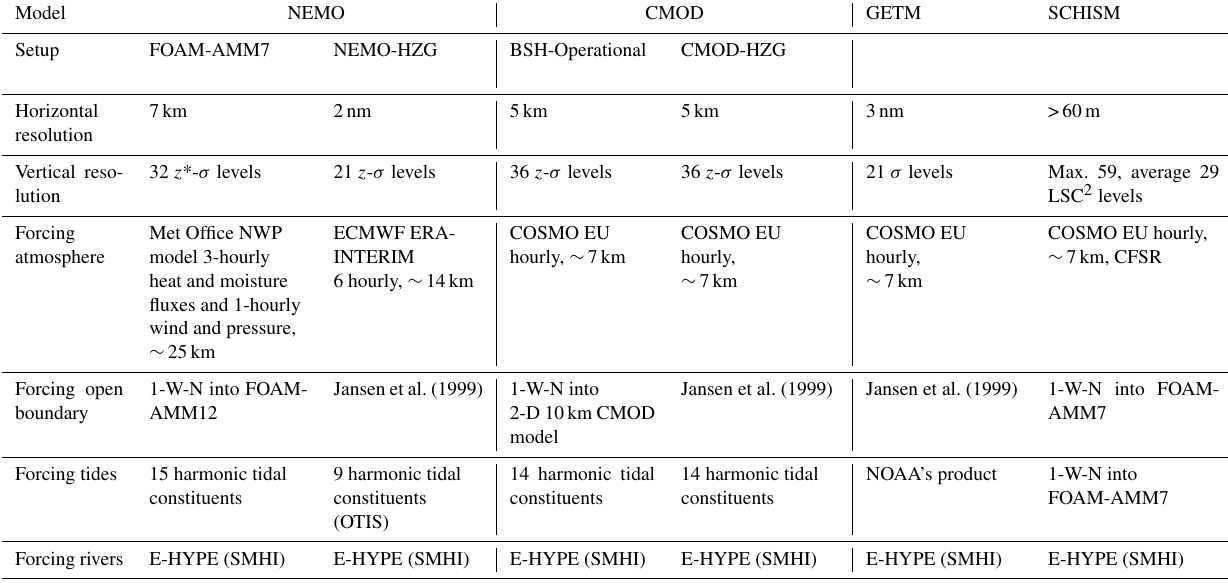
Table 1. Short presentation of major characteristics of the used models (for details, see the Appendix). Abbreviations: Numerical Weather Prediction (NWP); one-way nested (1-W-N). LSC 2 (Localized Sigma Coordinates with Shaved Cells; see Zhang et al. 2015) explains z *- σ . Model NEMO CMOD GETM SCHISM Setup FOAM-AMM7 NEMO-HZG